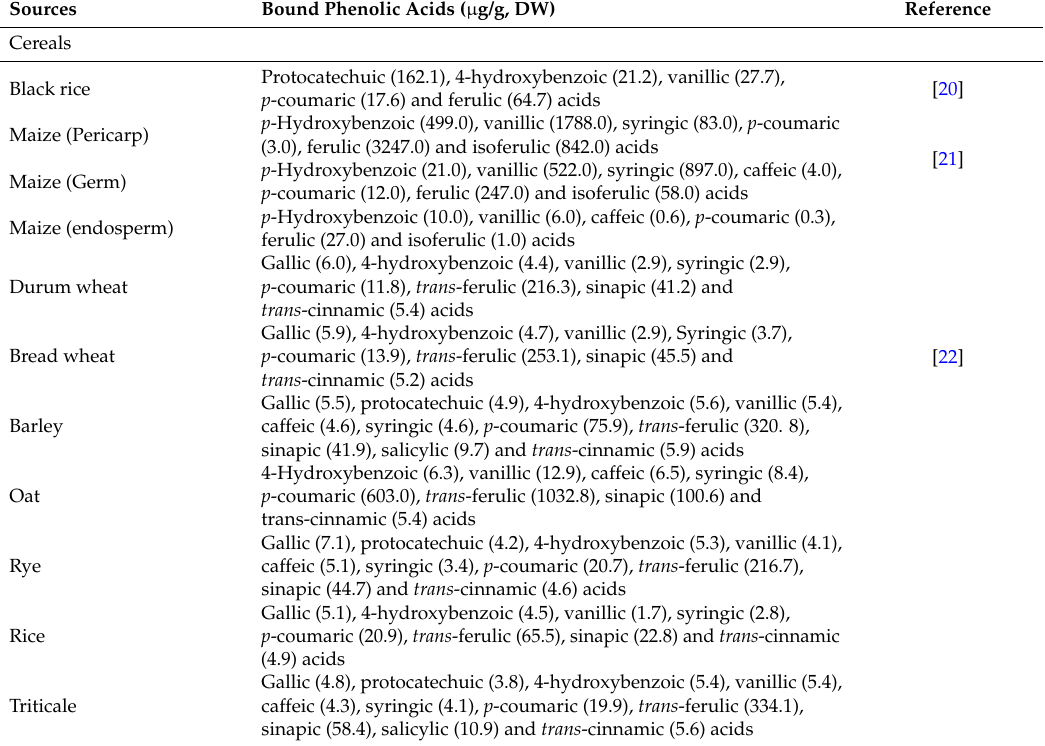
Table 1. Insoluble-bound phenolic acids in cereals, legumes and other